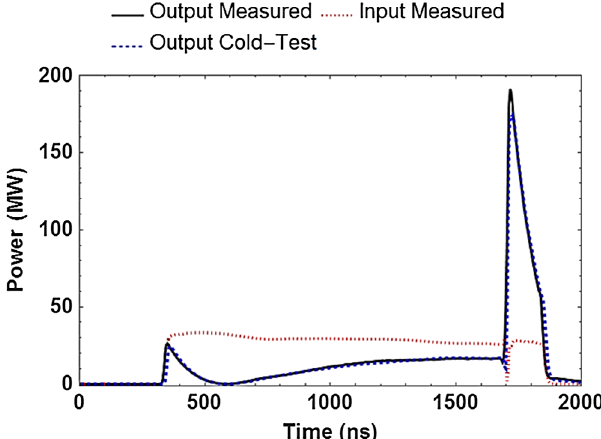
14. A chart showing the measured input pulse envelope (dotted:Red), the measured output pulse (black), and the predicted output pulse (dashed:Blue) based on the cold test